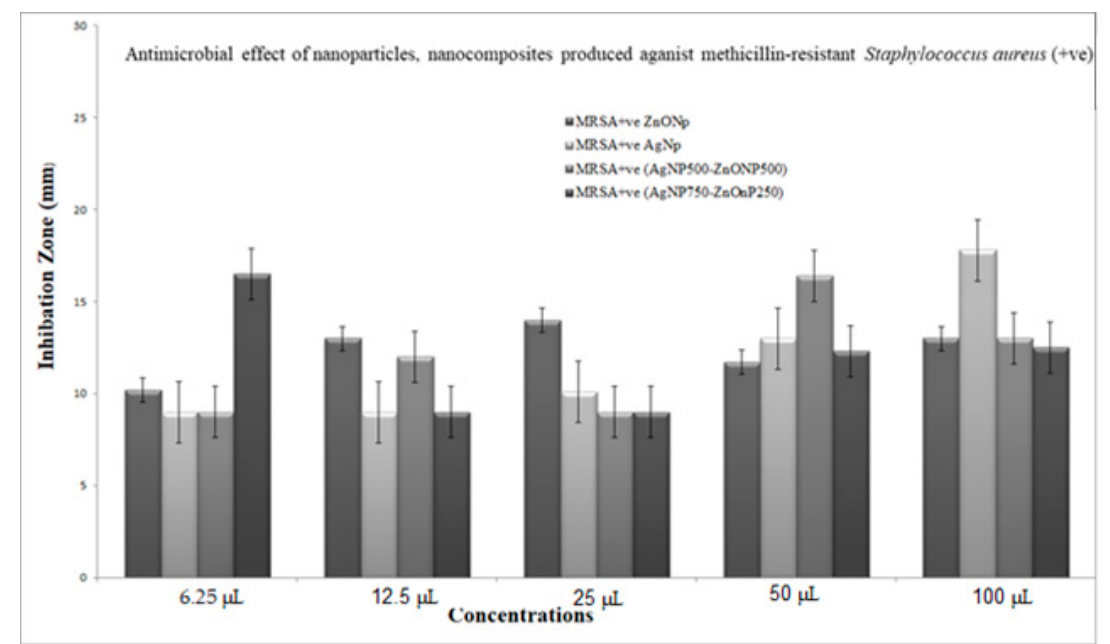
Figure 11. The antimicrobial activity of the nanoparticles and nanocomposite produced against human pathogenic microbe: MRSA sp. Data showing increasing inhibition zone with increasing amounts of nanoparticles: 6.25, 12.5, 25, 50 and 100 µ L with volume made up to 100 µ L with distilled water wherever needed. Zinc oxide nanoparticles (ZnONPs); silver nanoparticles (AgNPs); composite 500 µ L AgNPs–500 µ L ZnONPs; composite 750 µ L AgNPs–250 µ L ZnONPs nanoparticles. SD ± , standard